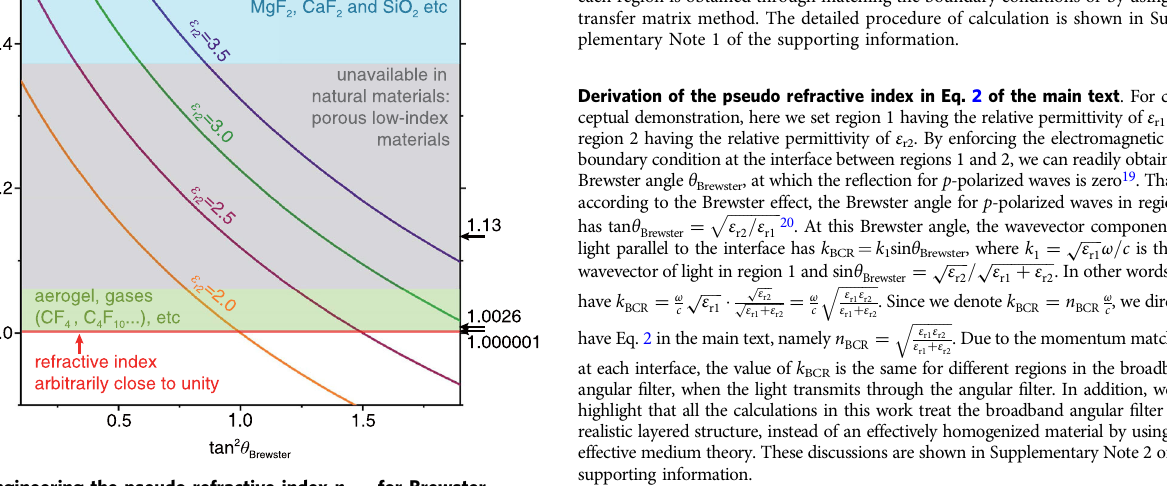
Fig. 1. All the fi elds of emitted light are calculated in the framework of electro- magnetic wave theory by applying the method of plane wave expansion. We let the z -axis parallel to the moving direction of a charged particle in Fig. 1; as such, the (cid:4) (cid:5) δ ð z (cid:3) vt Þ . The fi eld distribution in induced current density is (cid:1) J (cid:1) r ; t ð Þ ¼ ^ zqv δ x ð Þ δ y each region is obtained through matching the boundary conditions or by using the transfer matrix method. The detailed procedure of calculation is shown in Sup- plementary Note 1 of the supporting information.